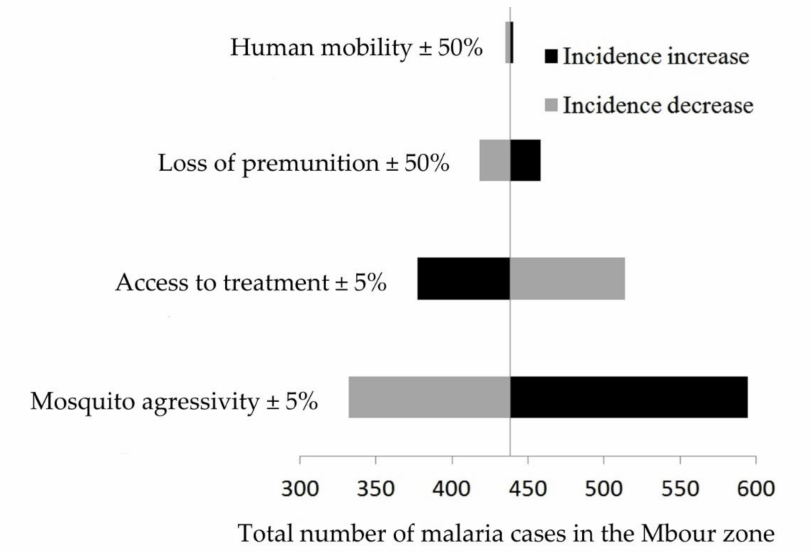
Figure 3. Sensitivity of model parameters in the malaria metapopulation model, Mbour, Senegal, 2008– 2012. Right and left correspond to a parameter increase and decrease, respectively. Black and gray bars respectively represent a increase and decrease in total malaria cases, subsequent to parameter